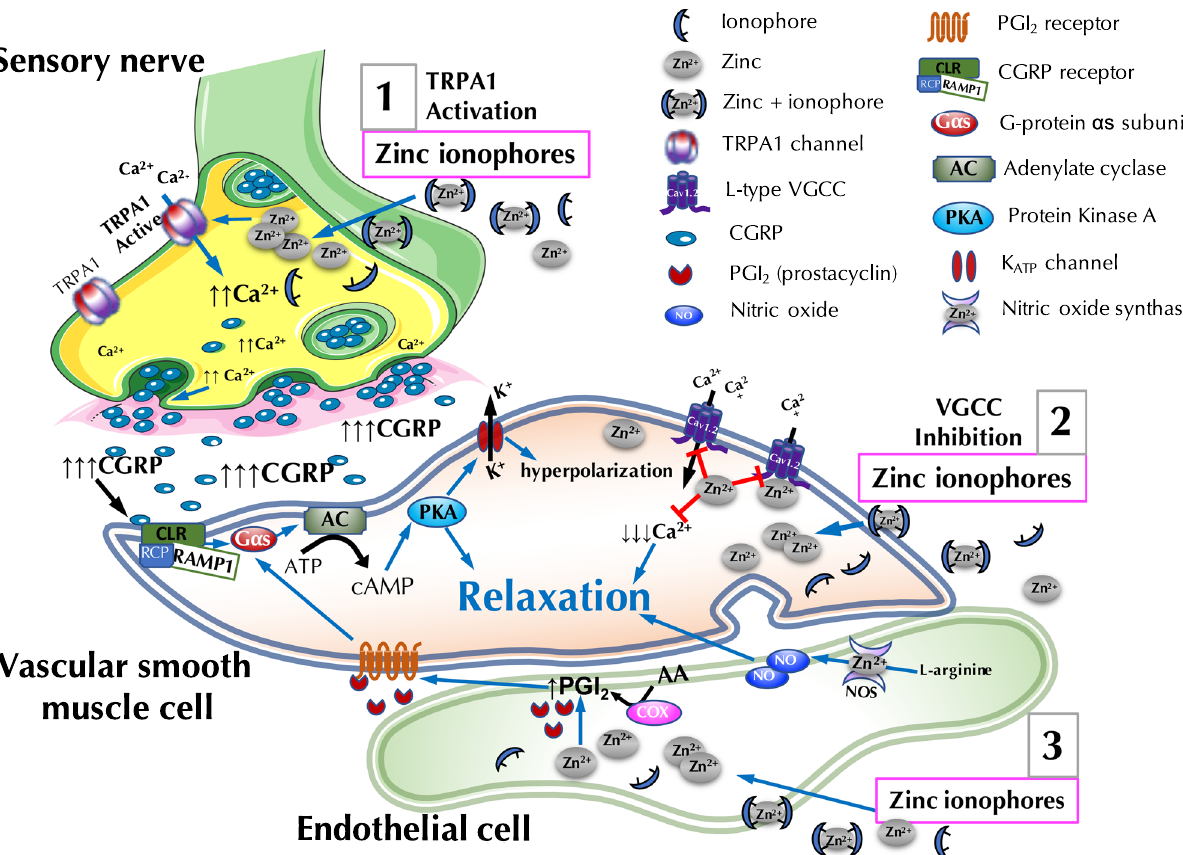
Fig. 7 Mechanism of zinc-mediated vasorelaxation. 1 Zinc in the cytoplasm of perivascular sensory nerves activates transient receptor potential ankyrin 1 (TRPA1) that causes calcium in fl ux and, in turn, releases calcitonin gene-related peptide (CGRP). CGRP binds to its G-protein coupled receptor (CLR-RAMP1-RCP) on the smooth muscle to cause cAMP-dependent hyperpolarization and relaxation. 2 Vascular smooth muscle cells are relaxed by cytoplasmic zinc that inhibits voltage-gated calcium channels (VGCC). 3 In the endothelium, increased cytoplasmic zinc using pyrithione and clioquinol causes relaxation of the smooth muscle by increasing dilatory prostanoid signaling. Nitric oxide synthase (NOS) function requires zinc, but its activity is not stimulated by excess zinc, rather it is inhibited by zinc deprivation. Image partly created with